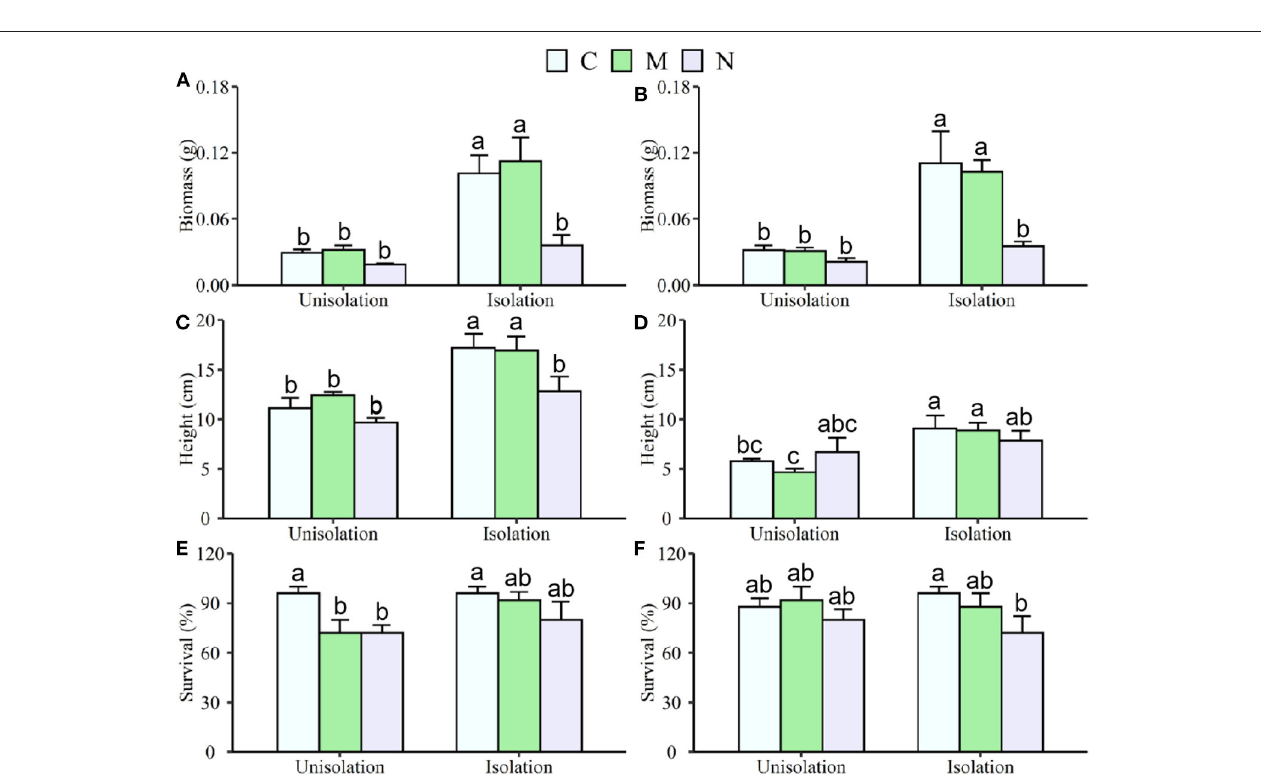
FIGURE 1 | Effects of root isolation7 on biomass, height, and survival of S. krylovii (A,C,E) and C. squarrosa (B,D,F) in control (C), mowing (M), and N addition (N) plots. Different lowercases indicate significant differences among the three treatments at p < 0.05.